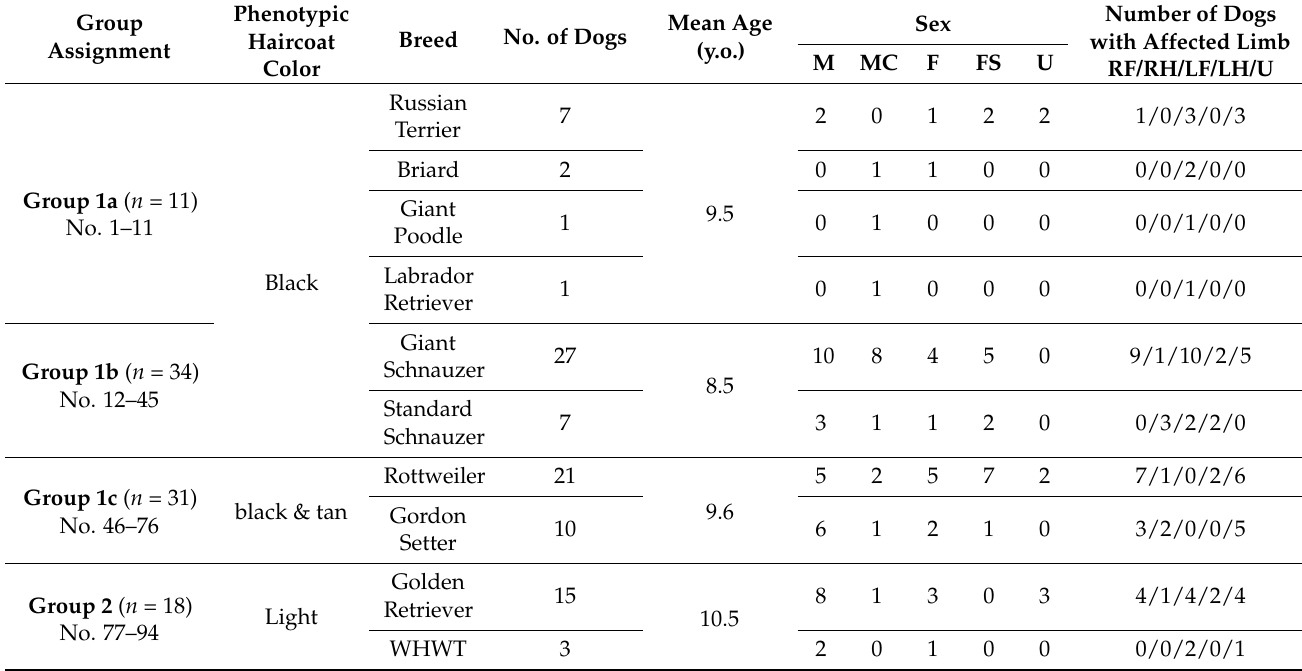
Table 1. Dog signalment and affected region with digital squamous cell carcinoma (DSCC) in the present study. Group